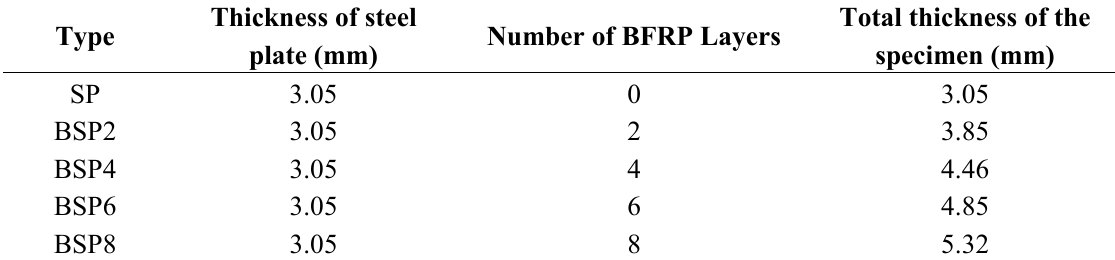
Table 2. Details of the